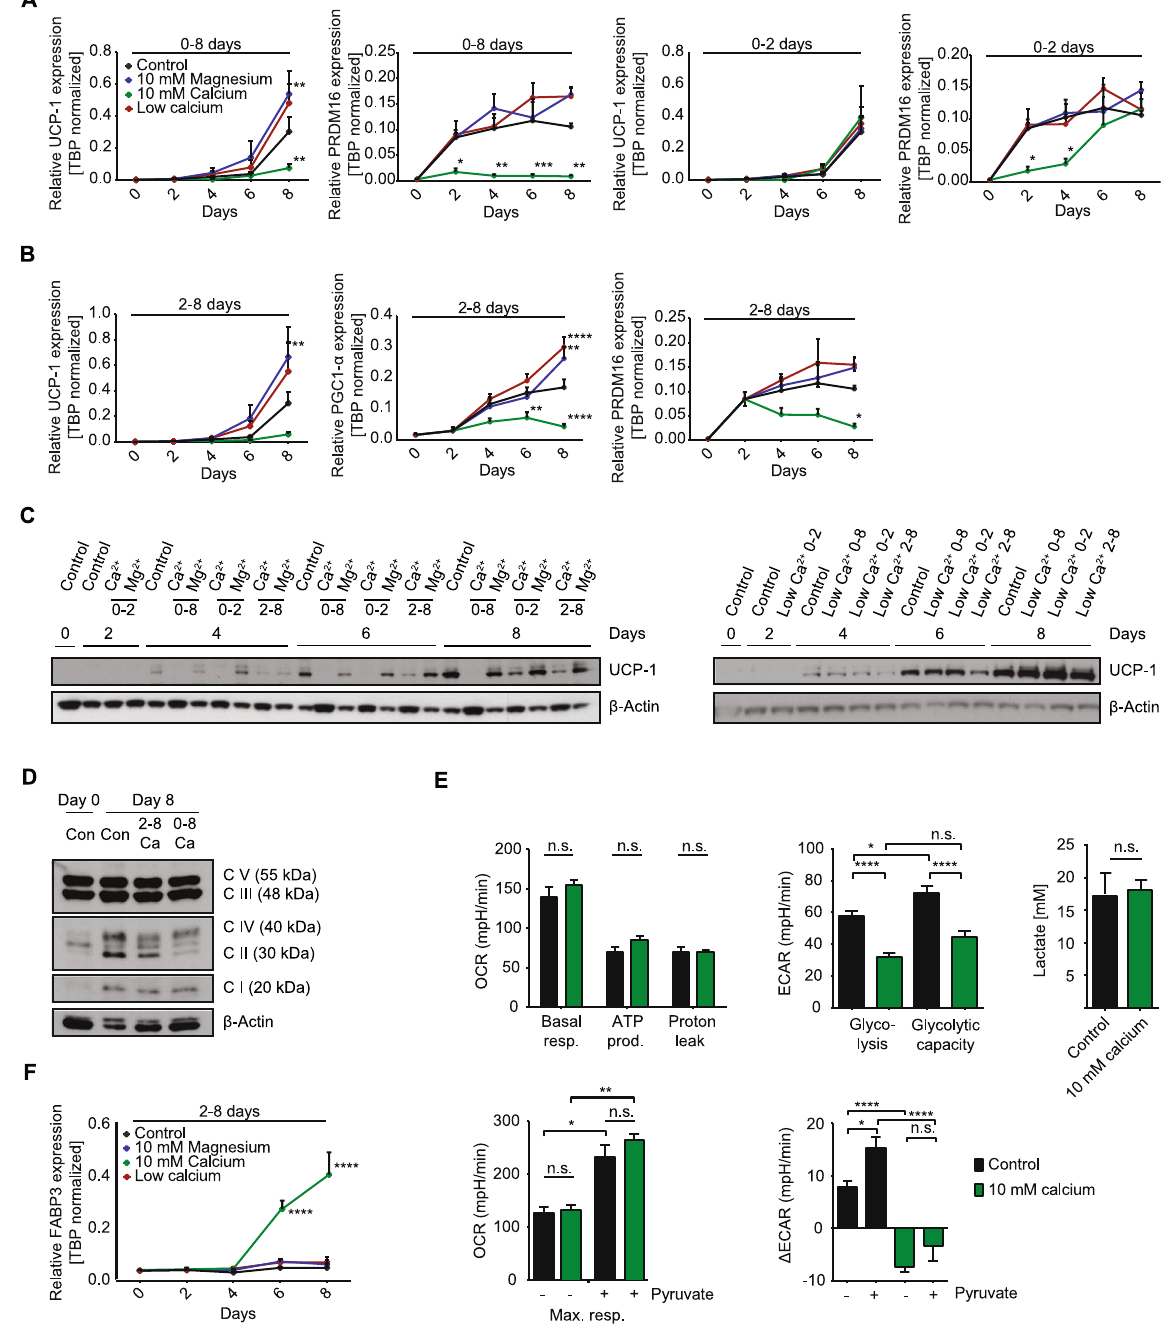
Figure 3. Extracellular calcium modulates brown adipocyte identity and thermogenic markers. ( A ) UCP1 and PRDM16 expression normalized to TBP of in vitro differentiated preadipocytes in an eight- day time course under normal 1.8 mM calcium (control), 10 mM calcium,10 mM magnesium and calcium free conditions for days 0–8 and days 0–2 (UCP1, PRDM16 n = 5). ( B ) UCP1, PGC1- α and PRDM16 expression normalized on TBP in these different treatment groups during days 2–8 (UCP1, PRDM16 n = 7, PGC1- α n = 4). ( C ) Western Blot for UCP1 and β -Actin during the eight - day time course of differentiation with normal 1.8 mM calcium (control), 10 mM calcium (Ca 2 + ), 10 mM magnesium (Mg 2 + ) or calcium free medium during indicated time points. ( D ) OxPhos Western Blot of preadipocytes (Con day 0) and differentiated adipocytes in 1.8 mM calcium (Con) or 10 mM calcium for days 2–8 or days 0–8 with β -Actin as loading control. ( E ) Oxygen consumption rate (OCR) and extracellular acidification rate (ECAR) in differentiated adipocytes at day 8 measured by the Seahorse extracellular flux analyzer. Cells were treated with 1.8 mM calcium (control) or 10 mM calcium for 2–8 days during differentiation. OCR was partitioned into basal respiration, ATP production, proton leak and maximal respiration, also in the presence of pyruvate (5 mM), while ECAR reported glycolytic rate, glycolytic capacity and the difference of glycolytic capacity ( Δ ECAR) before and after 5 mM pyruvate